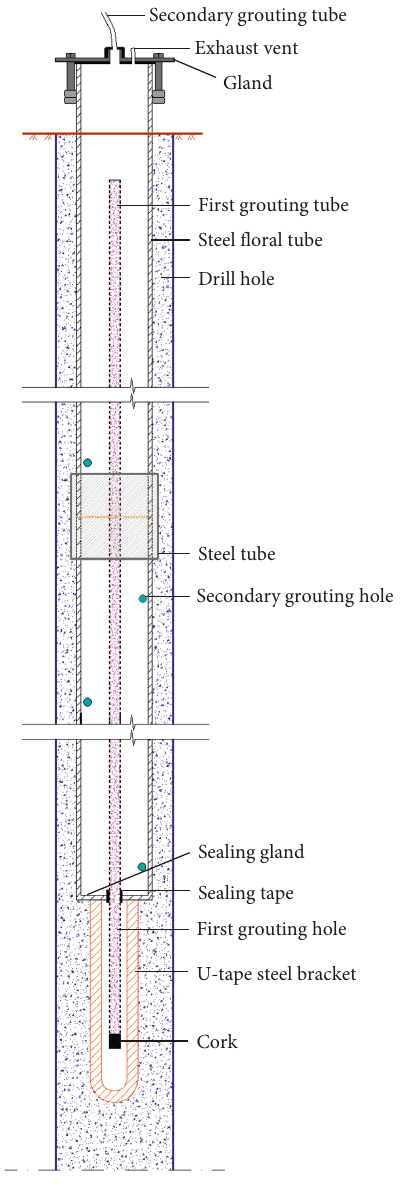
Figure 1: Structure of the single steel floral